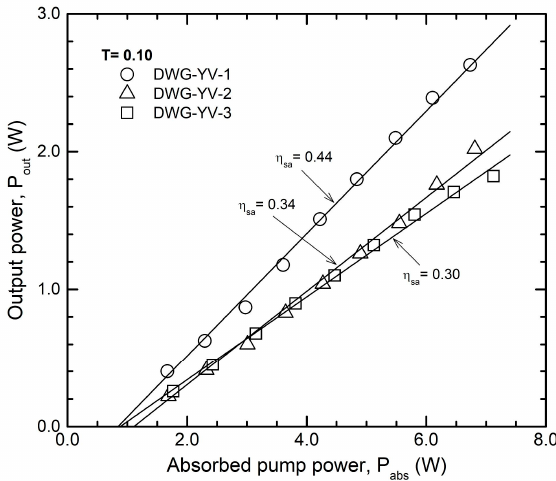
Figure 5. Cw operation for the waveguides inscribed in Nd:YVO 4 , OCM with T = 0.10.